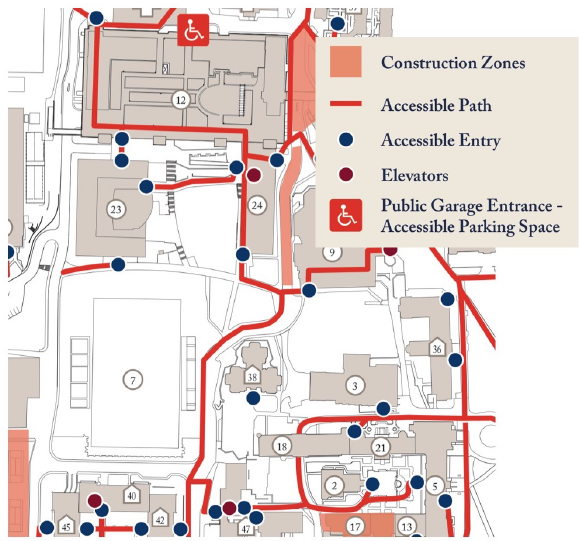
Figure 4. Georgetown University campus accessibility map.